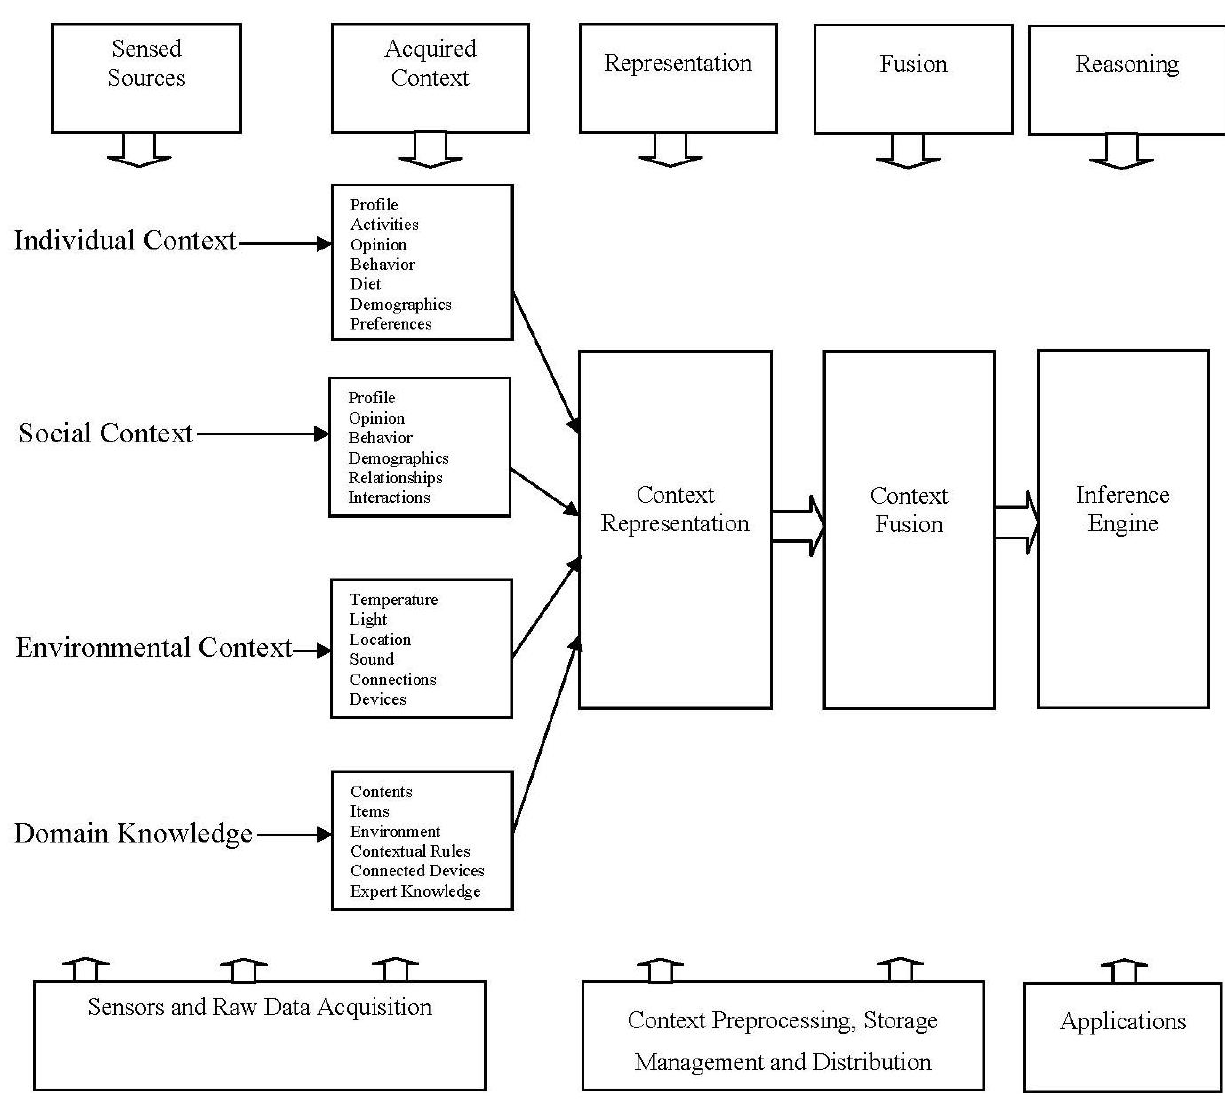
Figure 2. Overall system architecture and components (with associated functionality) of context-aware system design and development